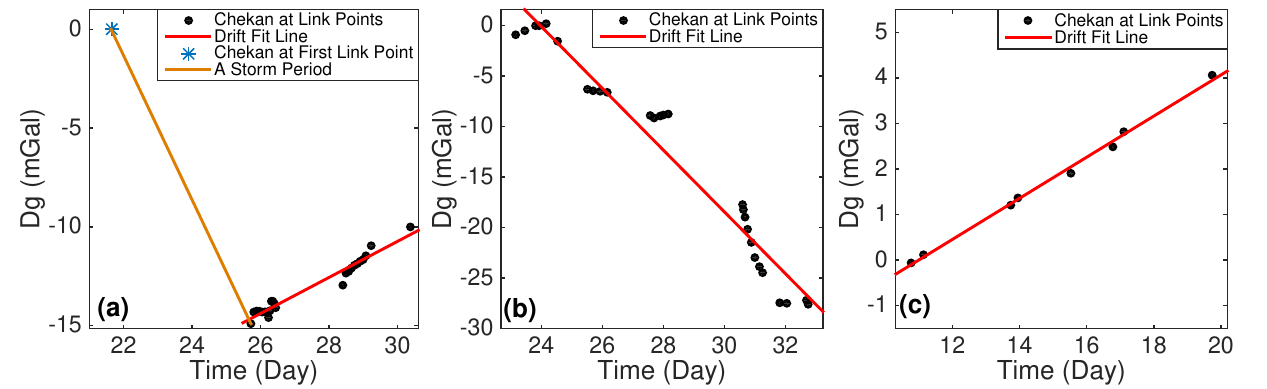
Figure 3. Drifts of different marine gravimetry campaigns onboard the research vessel DENEB: ( a ) a sudden change in gravimeter’s raw measurements of 6–7 mGal because of a storm and a negative drift after the storm in 2015, ( b ) an abnormal negative drift in 2016 and ( c ) a stable and normal positive drift in 2017 with the updated air-marine gravimeter Chekan-AM.